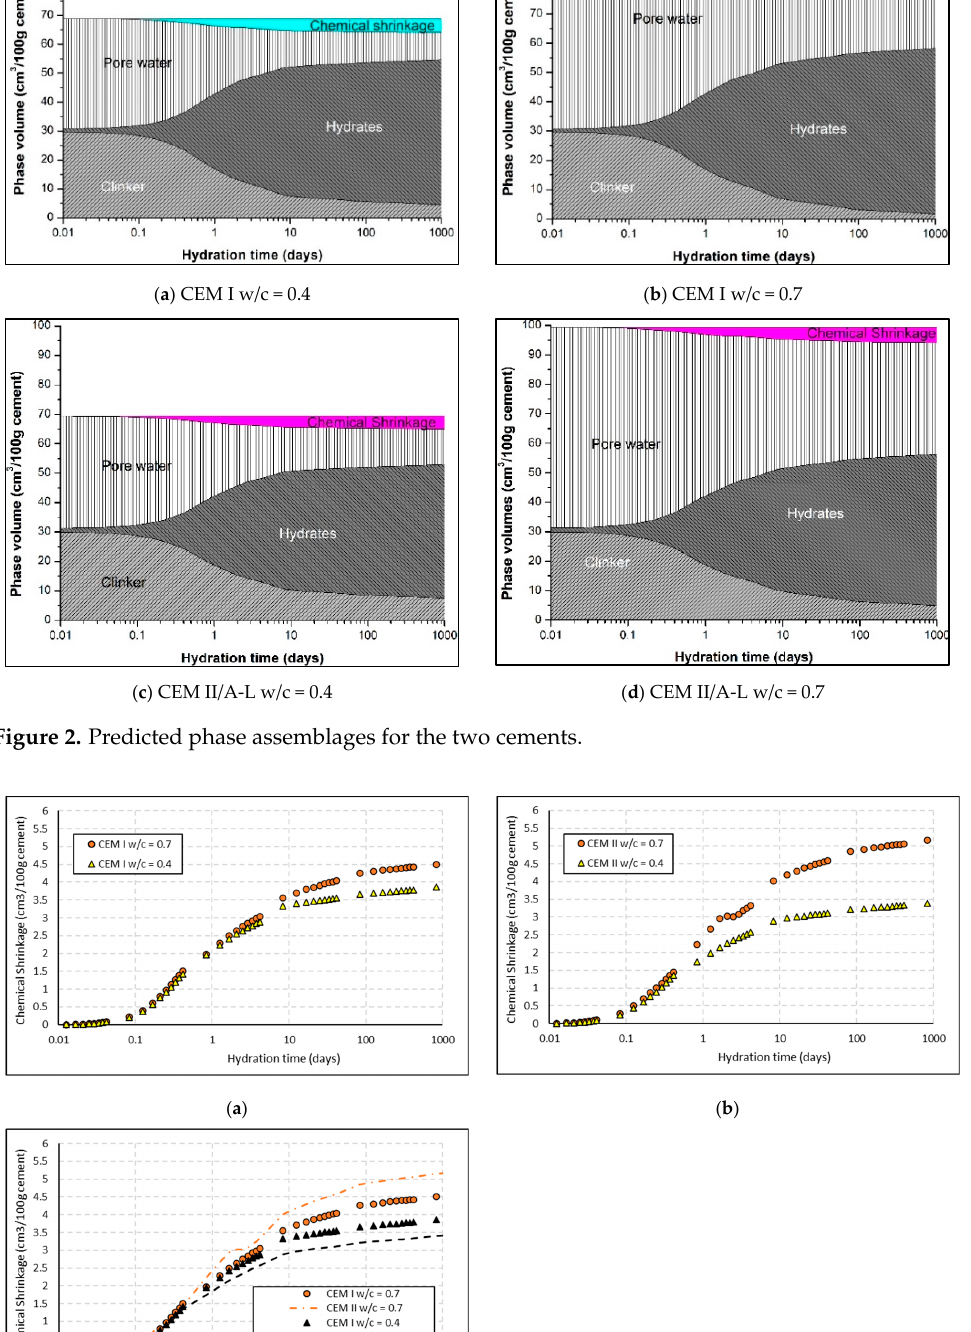
( b ) Figure 4. Relationship between predicted chemical shrinkage and degree of hydration (using [22]) for the ( a ) CEM I and ( b ) CEM II cements. Figure 5 shows a comparison between the predicted chemical shrinkage from the model here and experimentally measured data in the literature. As may be shown, there is reasonably good agreement between both, irrespective of the type of cement.